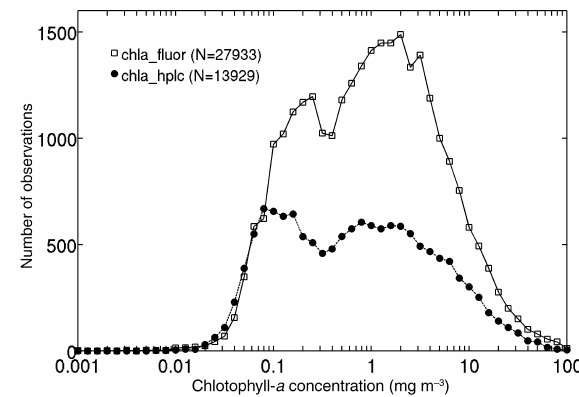
Figure 7. Number of observations per chlorophyll a concentration acquired with different methods ( chla_fluor and